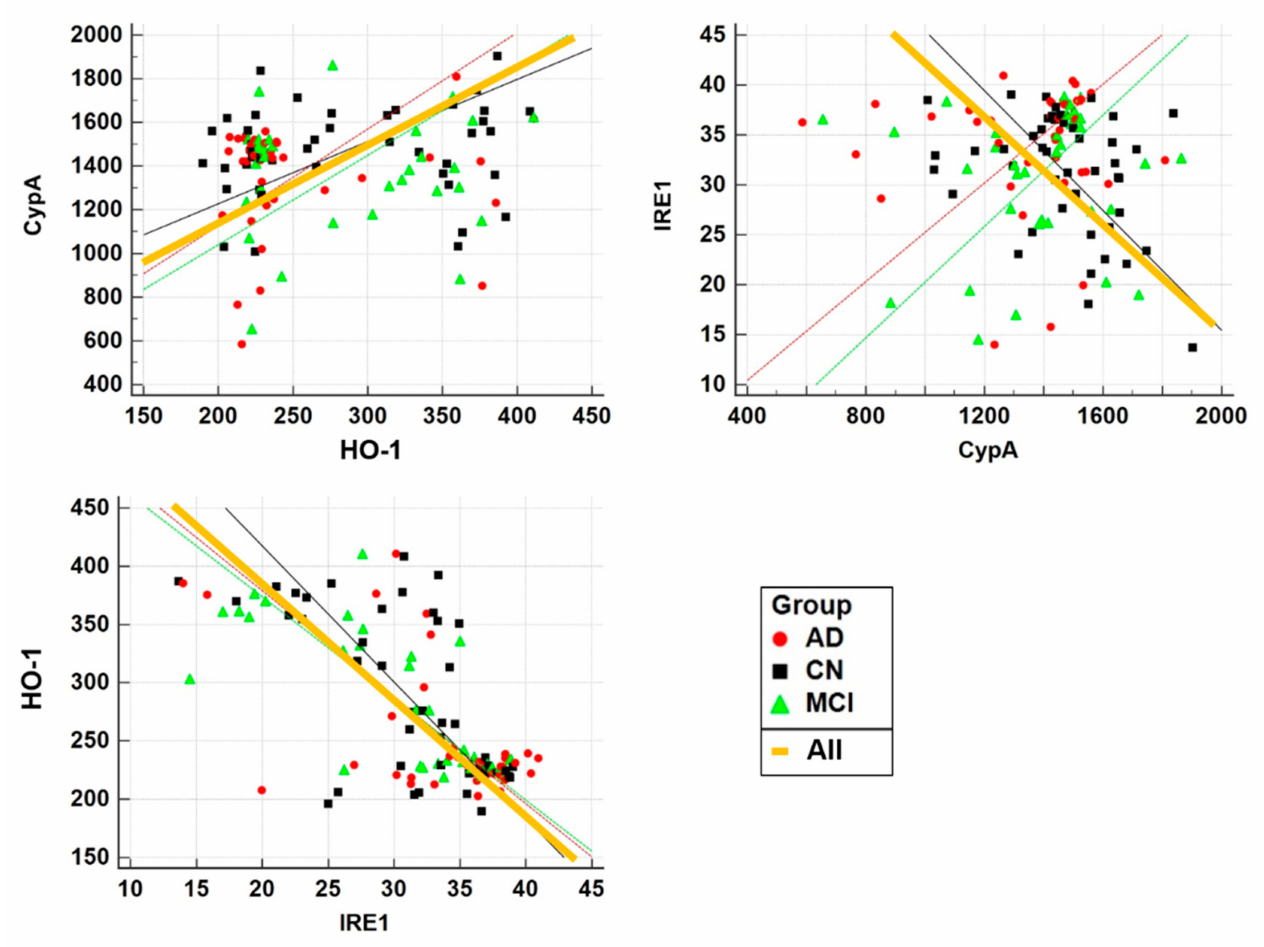
Figure 1. Pearson correlation analyses of the levels of the three blood-based biomarkers in all participants and in subgroups. CypA, cyclophilin A; HO-1, heme oxygenase-1; IRE1, inositol-requiring enzyme 1; CN, cognitive normal; MCI, amnestic mild cognitive impairment; AD, Alzheimer’s